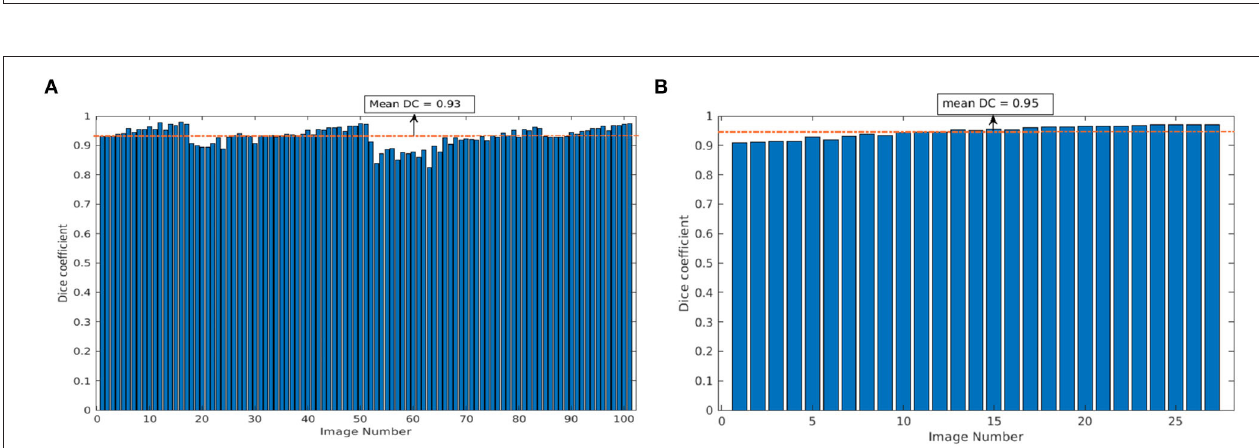
FIGURE 6 | Segmentation performance on variational data sets: DC of stress and multi-tray experiments are 0.9664 and 0.9873, respectively. (A) Stress experiment image, (B) Ground truth, (C) Predicted segmentation, (D) Multi-tray image, (E) Ground truth, and (F) Predicted segmentation.